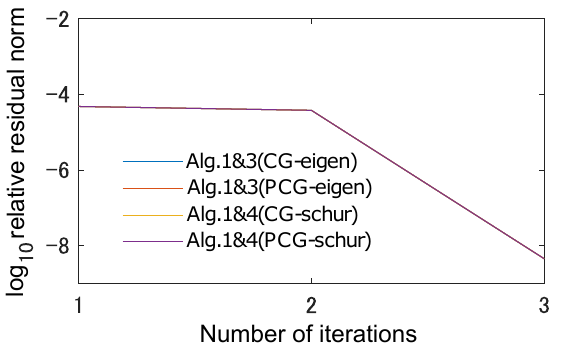
Figure 1. Convergence histories with relative residual norm of the Lanczos method for the 5-th max. singular value of the almost symmetric matrix T whose size is n = 15.